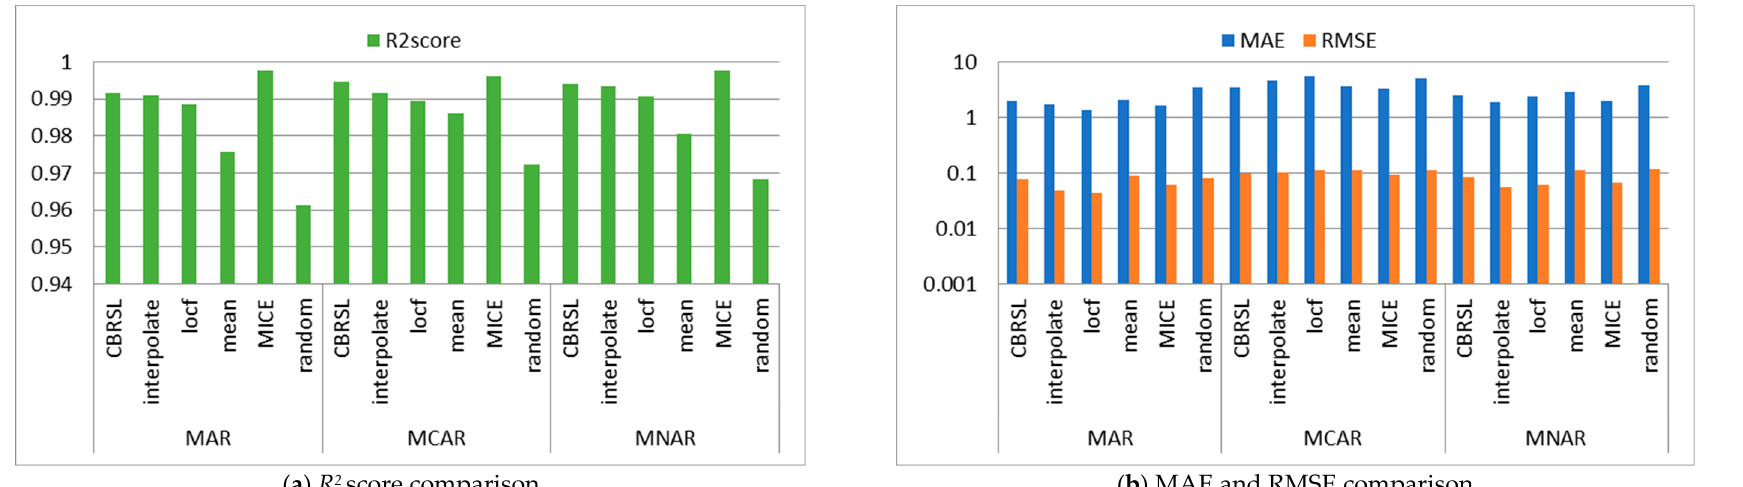
Figure 5. Comparison between the proposed algorithm, interpolate, locf, mean, MICE and random methods (Pima Indians Diabetes Dataset).